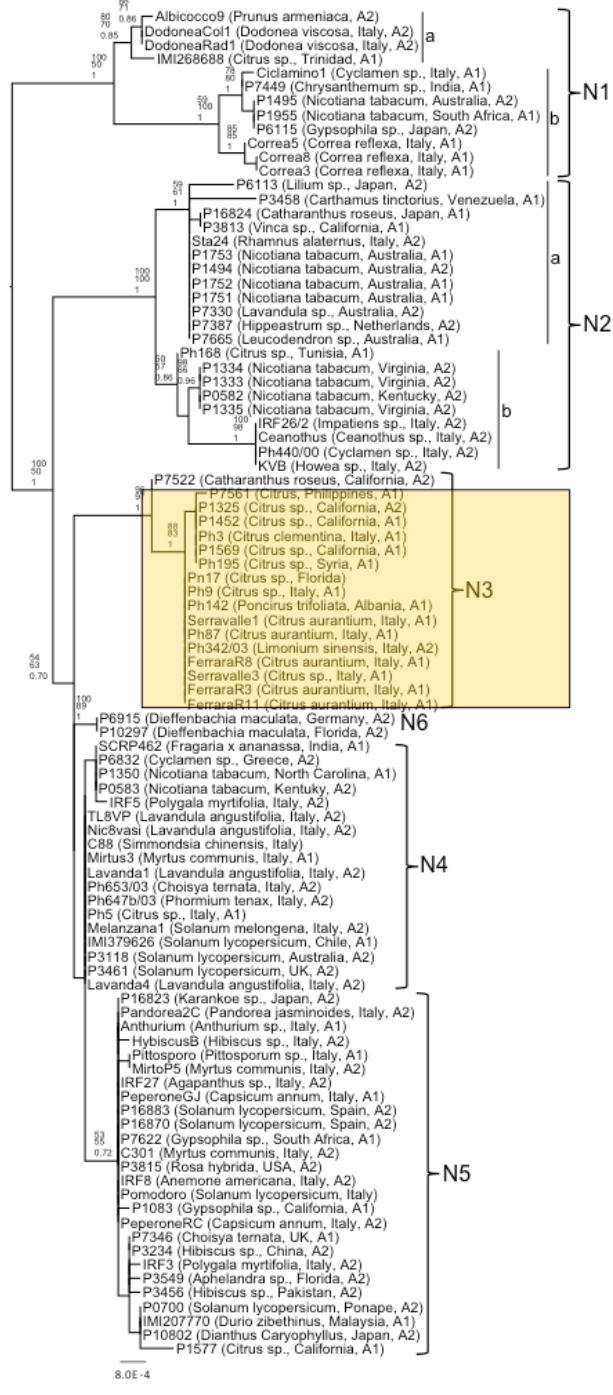
Figure 2. Phylogenetic relationships among isolates of Phytophthora nicotianae based on the combined dataset of sequences of the four mitochondrial regions (trnG-rns, rns-cox2, cox2+spacer, atp1-nad5), using maximum parsimony, maximum likelihood, and Bayesian methods. Adapted from Mammella et al. , (2013). Citrus isolates form a distinct clade, illustrated by the yellow